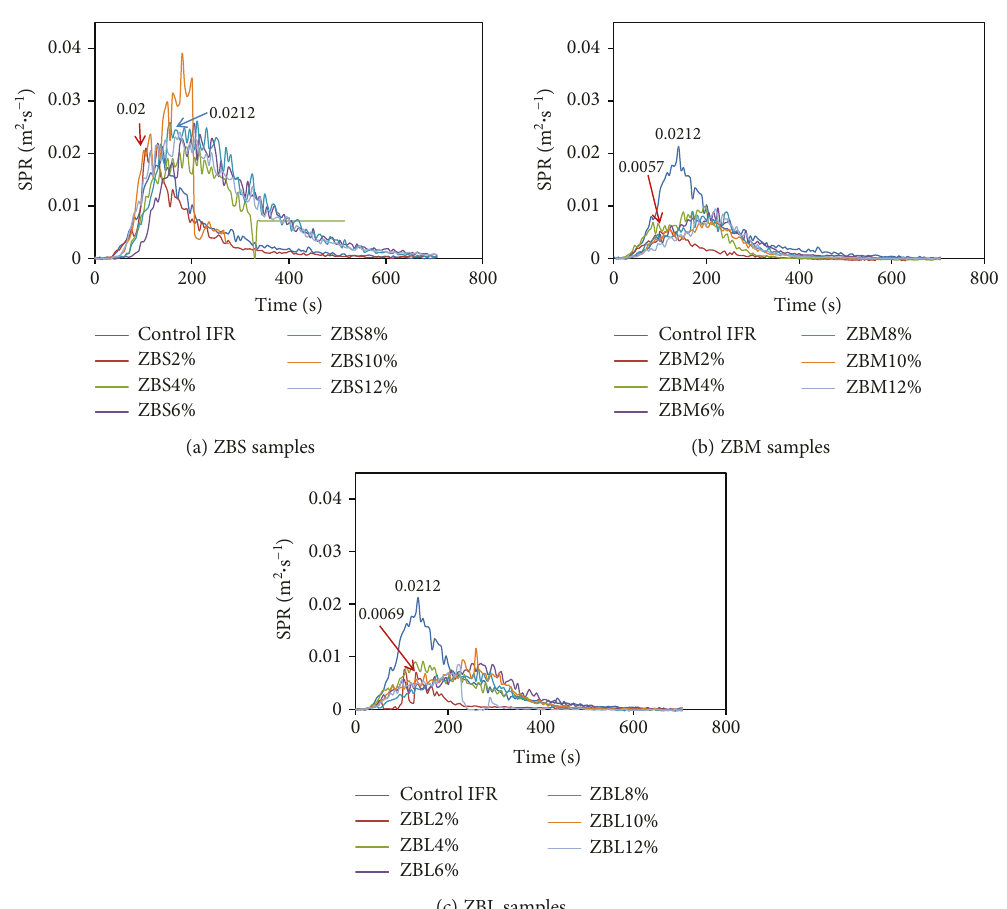
Figure 4: Smoke production rate of wood treated with IFR/ZB